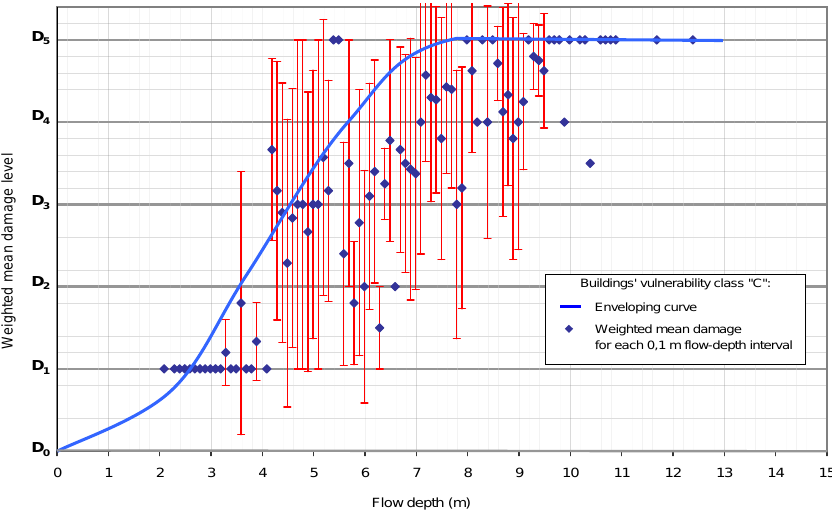
Fig. 8. Enveloping curve for building vulnerability class “C”. Standard deviation for mean damage level ¯ D i is shown with red bars.